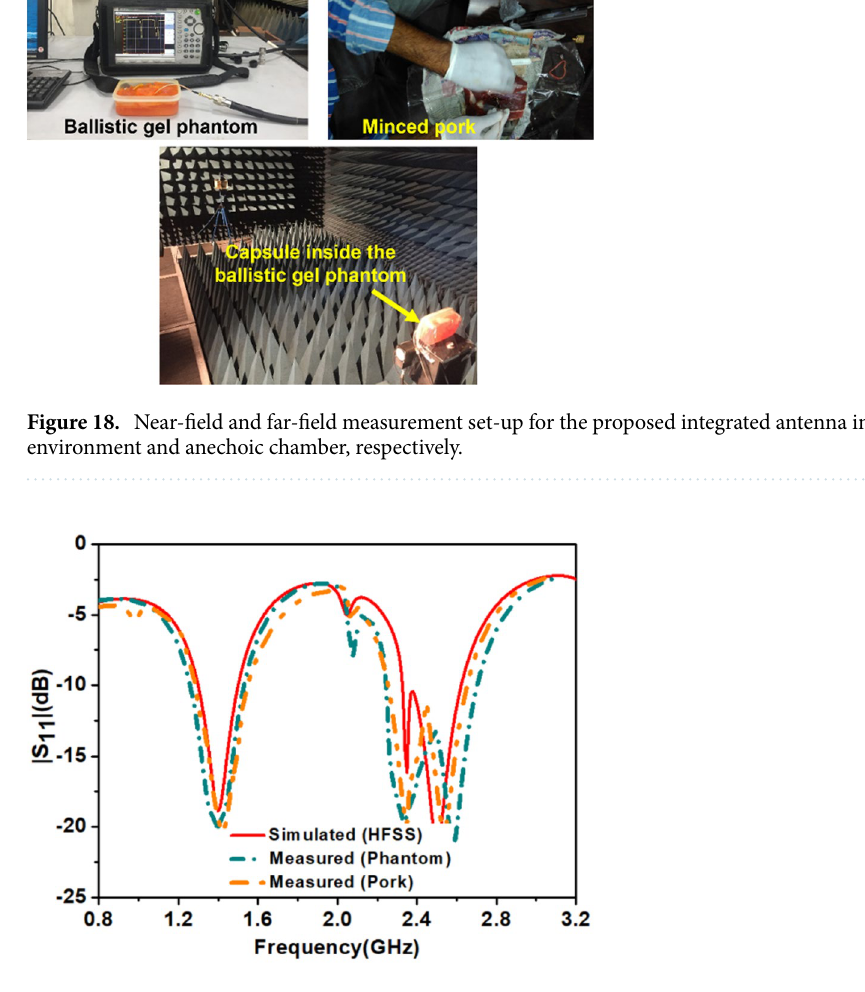
Figure 19. Comparison of simulated and measured (|S 11 |).